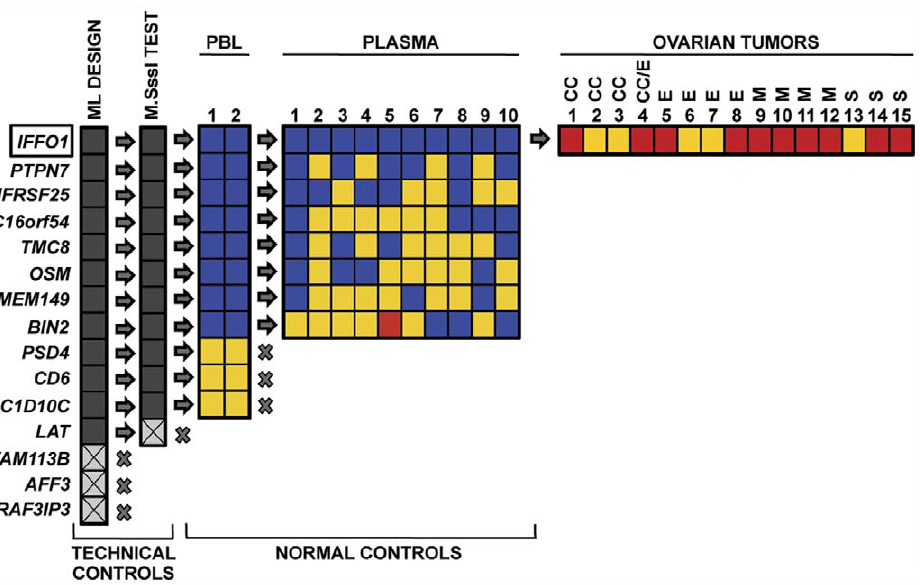
Figure 4. Representation of the verification phase on the MethyLight platform of the top-ranked 15 DNA methylation markers. Technical controls for the MethyLight (ML) platform led to the elimination of four markers (crossed gray boxes) due to design incompatibility, and failure to amplify the in vitro methylated DNA positive control for MethyLight reactions (M.SssI test). Eleven markers were tested in normal PBL samples using an excess of PBL DNA (50 ng). Markers with a cycle threshold (Ct) higher than 35 (blue boxes) in the two normal PBL samples were retained and markers with a Ct less than 35 (yellow boxes) were eliminated. MethyLight assays with Ct values , 35 indicate appreciably detectable amounts of methylated DNA at these loci. Further testing in normal control plasma samples (100 m l) resulted in the elimination of seven of the eight remaining markers. One remaining marker, IFFO1 , was tested in 15 ovarian cancers of different histological subtypes. The MethyLight results for the normal plasma control and the ovarian cancer samples are expressed as Percent of Methylated Reference (PMR). Blue boxes represent PMR values less than 10, yellow boxes indicate PMR values between 10 and 50, whereas red boxes signify PMR values higher than 50. The types of ovarian tumors used in the analysis are as follows: clear cell carcinomas (CC), mixed clear cell and endometrioid (CC/E), endometrioid (E), mucinous (M), and serous (S).